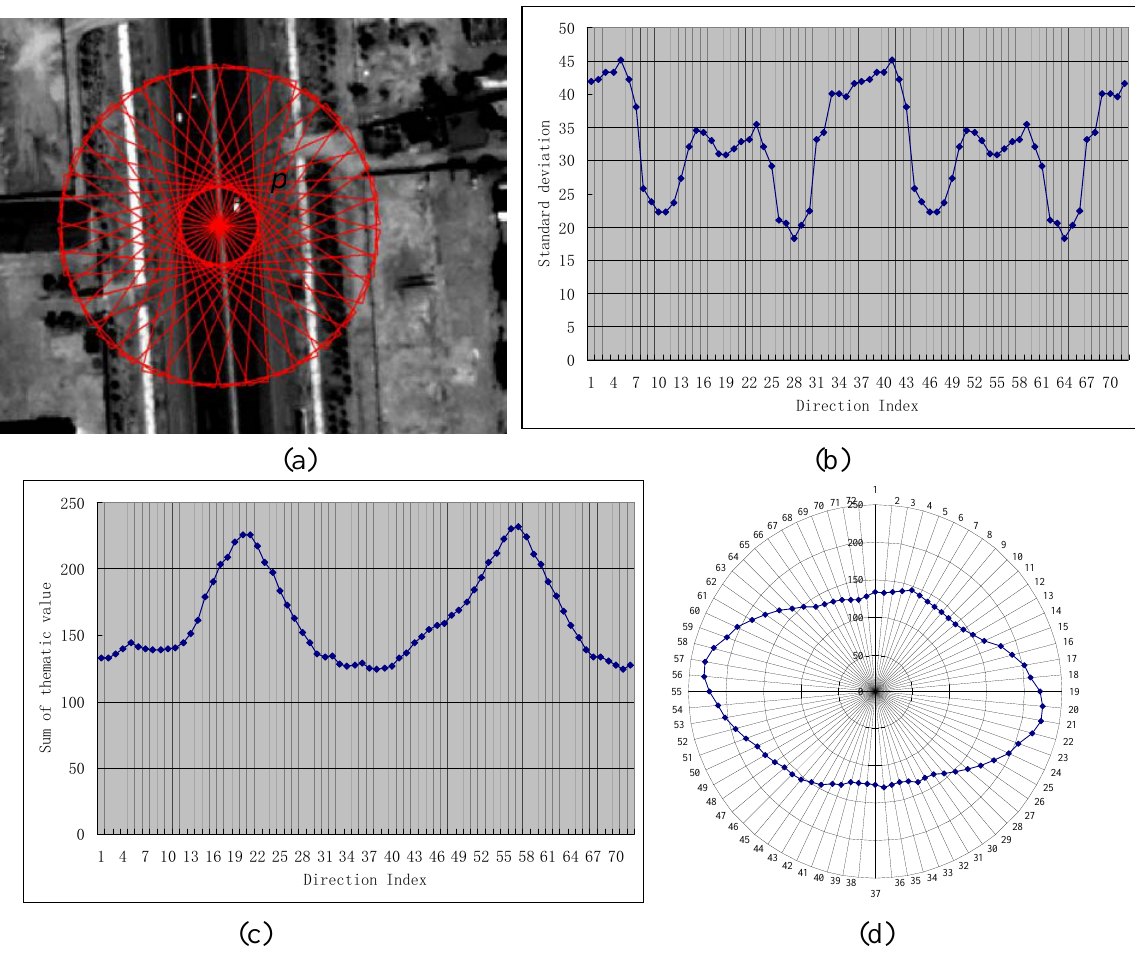
Figure 2. Angular Texture Signature. (a) Texture is computed over a set of rectangular regions rotating around a road centerline point (note that there are 72 templates but only odd ones are displayed); (b) the graph of the ATS; (c) the graph of the PATS; (d) the PATS polygon of